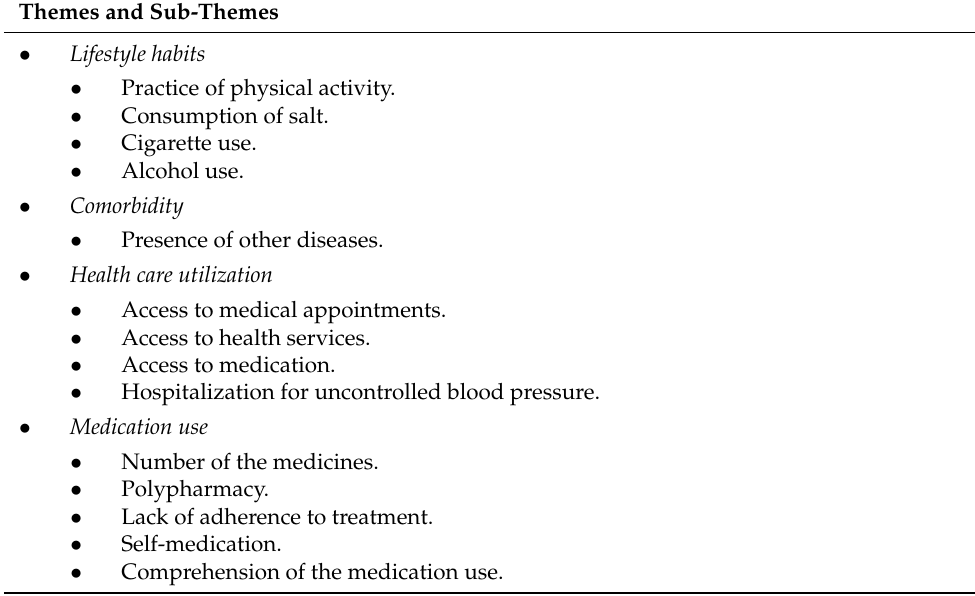
Table 1. Summary of the main themes identified in this study. Themes and